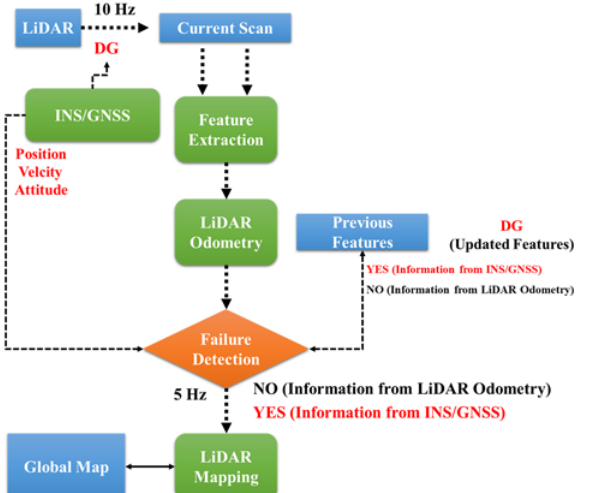
Figure 3. SLAM-aiding INS/GNSS